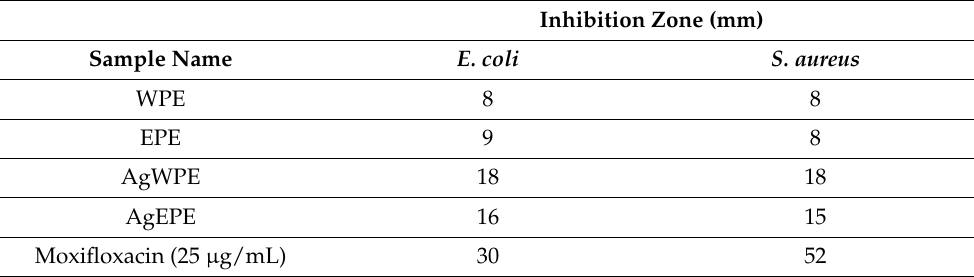
Table 7. Antibacterial activity of the extracts and synthesized silver nanoparticles (AgNPs) against E.coli and Staphylococcus aureus .